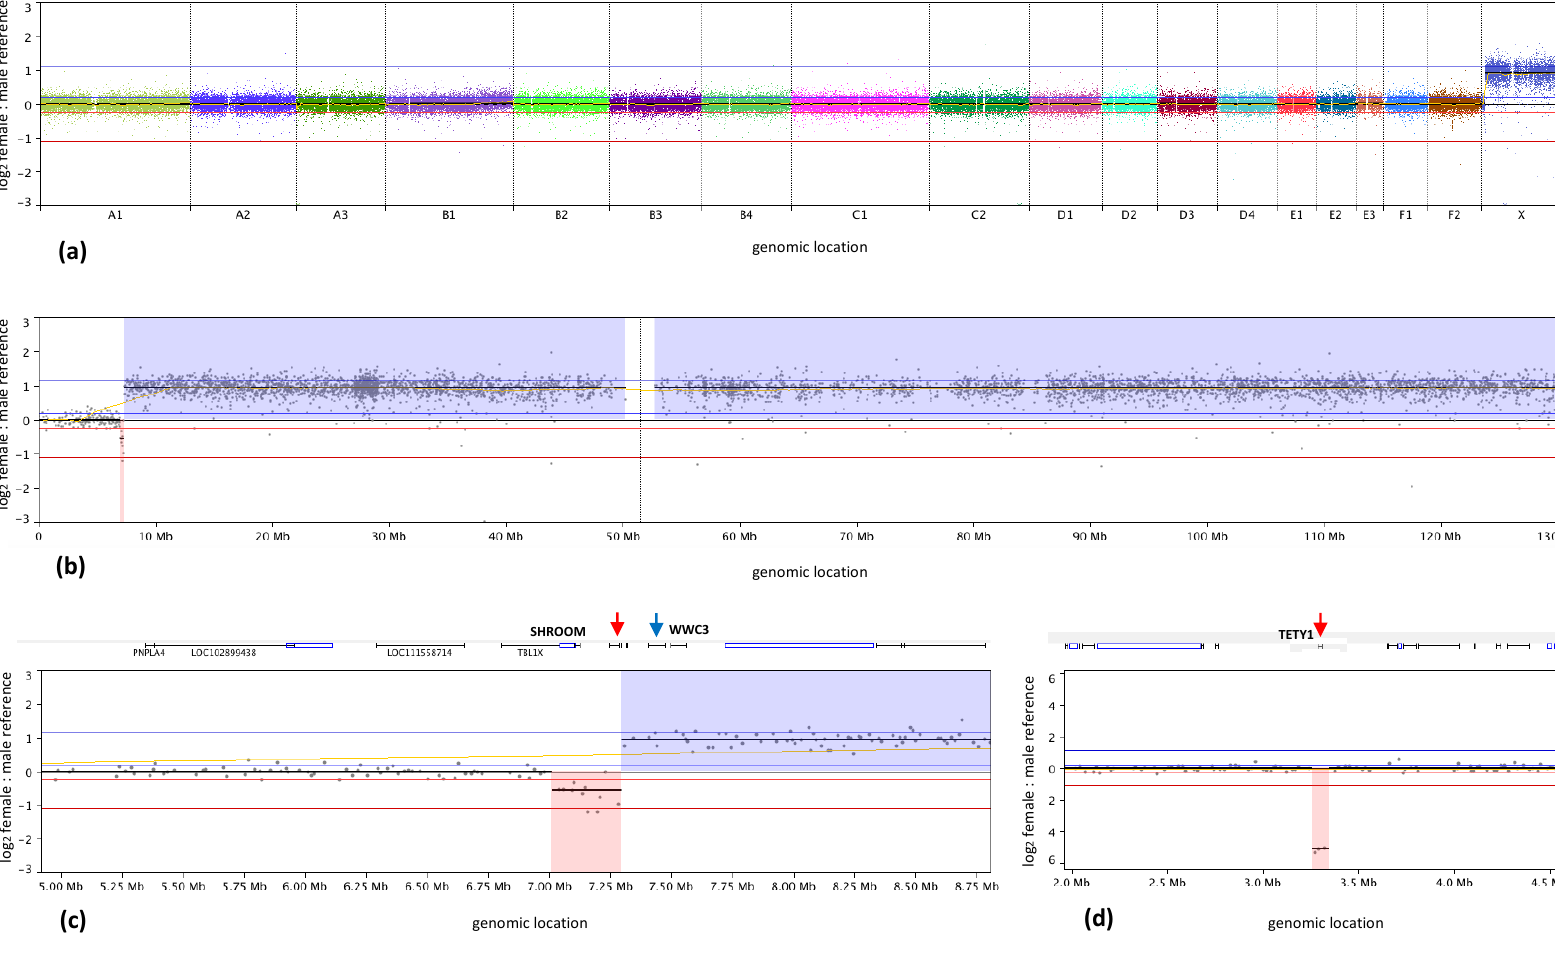
Figure 2. Genomic profile of female reference DNA hybridized against male reference DNA. Feline genomic locations are plotted along the x-axis, and relative log 2 fluorescence intensity ratios are plotted on the y-axis. Each datapoint represents the female:male DNA copy number ratio (y-axis) of the corresponding arrayed probe sequence as determined by oaCGH analysis. The horizontal midline (y = 0) indicates relative genomic balance between the female and male reference DNA